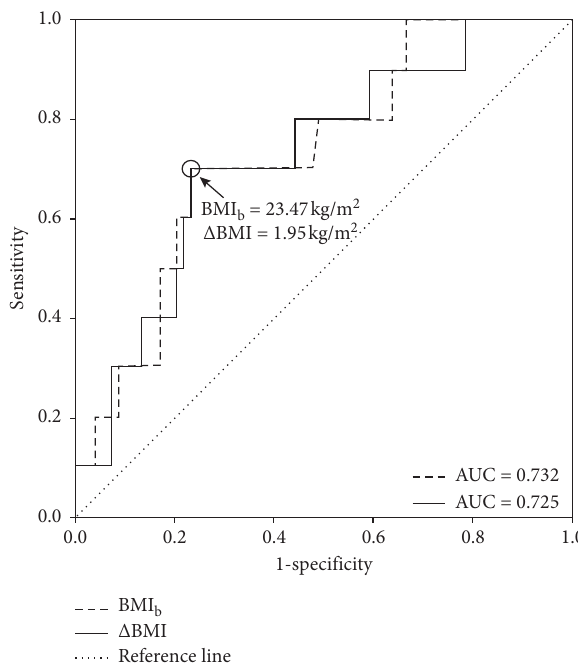
Figure 2: The receiver operation characteristic (ROC) curve for baseline BMI (BMIb) and the change of BMI ( Δ BMI) in 5 years to predict metabolic syndrome (MetS) at follow up. AUC, area under the curve; O, the optimal cutoff of BMIb; Δ BMI for identifying